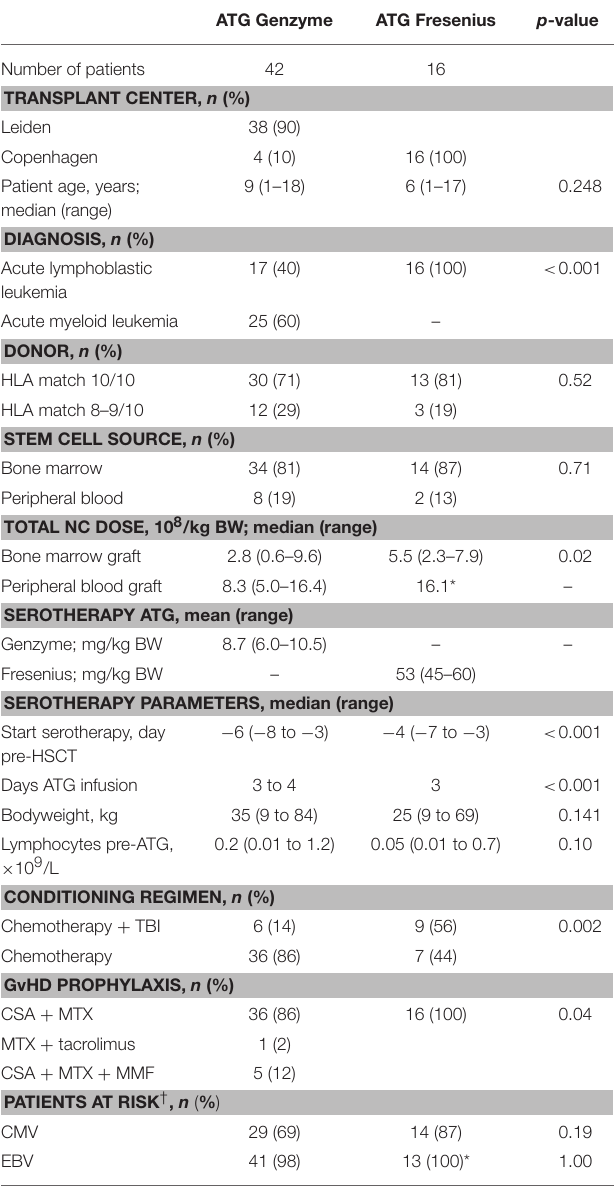
TABLE 1 | Patient characteristics ATG-Genzyme and ATG-Fresenius groups. ATG Genzyme ATG